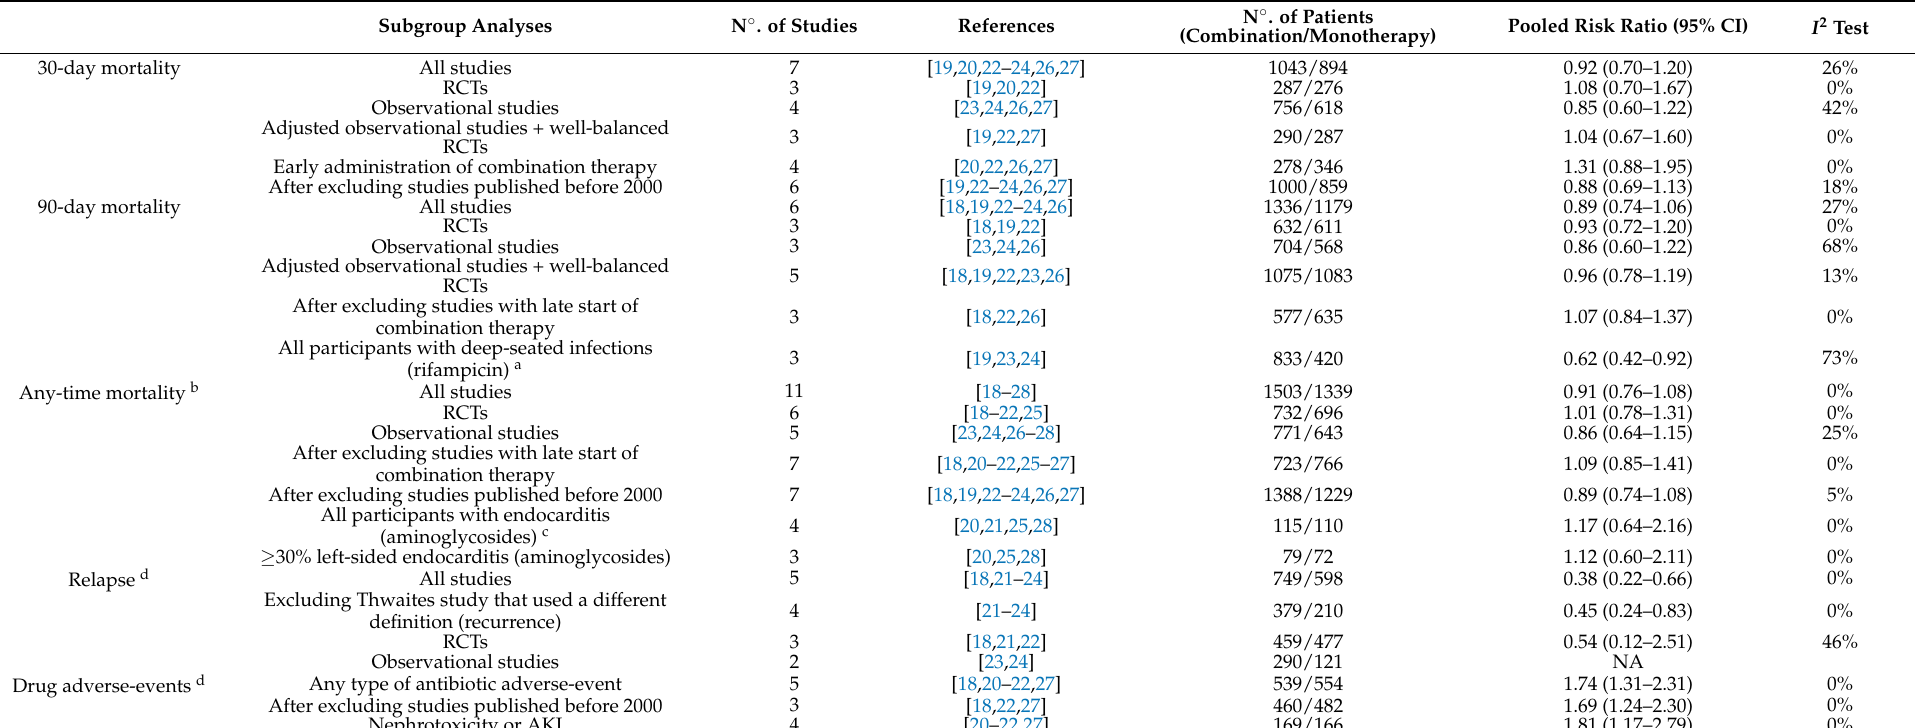
Table 2. Summary of the subgroup analyses